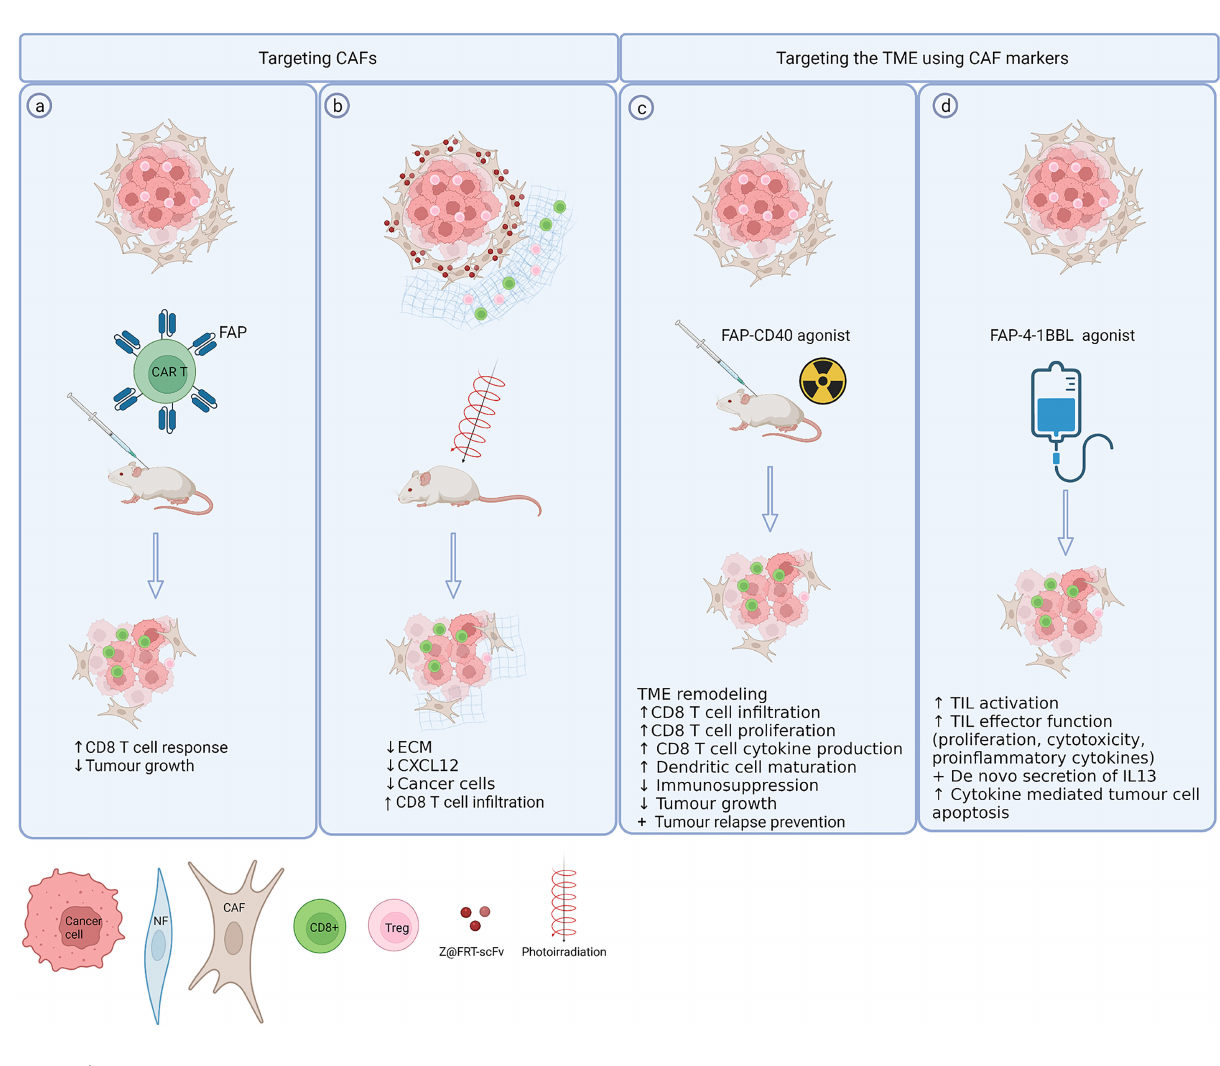
FIGURE 2 | Exploiting CAF markers to selectively target CAFs and the TME. (A) Directly targeting CAFs using FAP speci fi c CAR T cells results in reduced tumour growth depending on increased CD8 T cell responses (81, 82). (B) A FAP speci fi c single chain variable fragment conjugated to ferritin (Z@FRT-scFv) allows nanoparticle based photoimmunotherapy of CAFs resulting in tumour suppression via ECM, CXCL12 reduction and CD8 T cell in fi ltration (84). (C, D) Expression of FAP can be exploited to selectively deliver co-stimulatory agents [CD40 (87), 4-1BBL (88)] to the TME thereby avoiding systemic toxicity. Created with